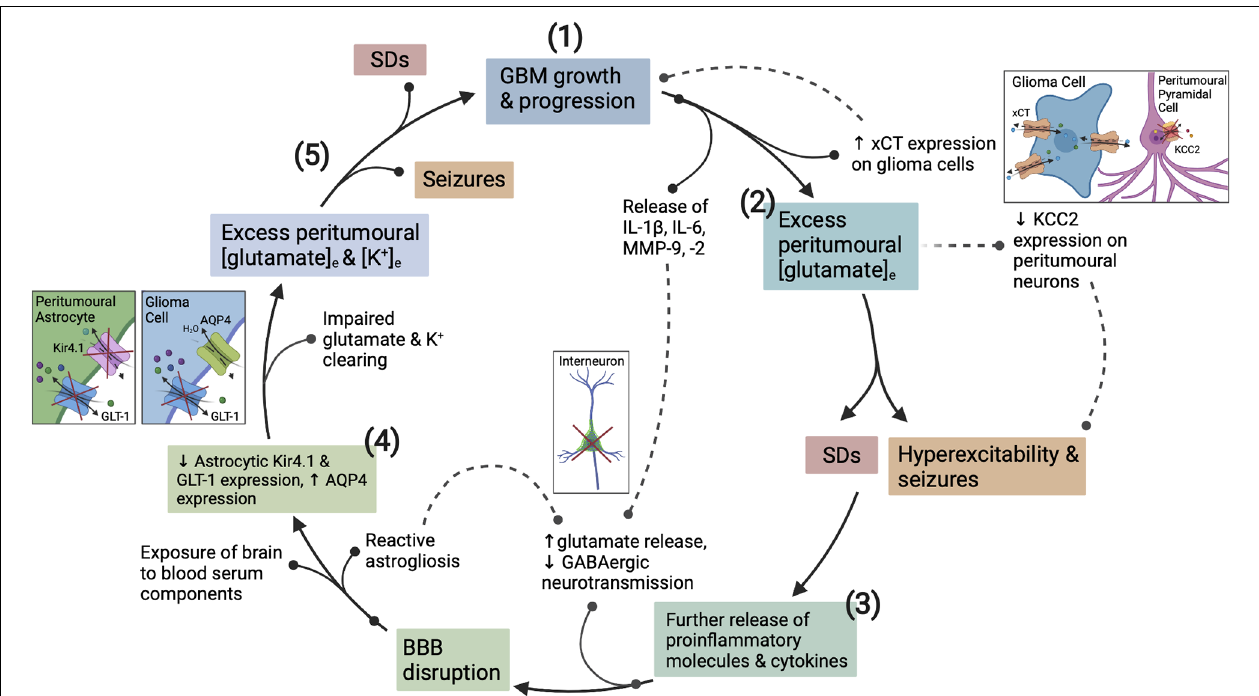
FIGURE 2 | The vicious cycle of hyperexcitability in glioblastoma (GBM) progression. How epileptogenesis is initiated, is influenced by, and contributes to GBM growth. (1) GBM growth and its interaction with neuronal/glial cells initiates the cycle to epileptogenesis. (2) Upregulation of xCT on glioma cells and downregulation of KCC2 on surrounding pyramidal neurons creates an initial imbalance between excitatory and inhibitory neurotransmission. (3) Pro-inflammatory cytokines and MMPs present in the GBM TME act to degrade the PNNs surrounding GABAergic interneurons. (3) Once epileptogenesis has been initiated, further proinflammatory cytokine, K + , and glutamate release exacerbates BBB disruption and encourages network reorganization creating a microenvironment conducive to SDs. (4) The function of Kir4.1, AQP4 and GLT-1 transporters is disrupted by recurrent seizures and SDs, and via actions of GBM. (5) This dysfunction continues in a cyclical fashion whereby seizures promote more seizures and SDs, and the associated pathological downstream signaling actively potentiates glioma cell proliferation, and vice versa . BBB, blood brain-barrier; TME, tumor microenvironment; MMPs, matrix metalloproteinases; PNNs, perineuronal nets; SDs, spreading depolarizations; APQ4, aquaporin